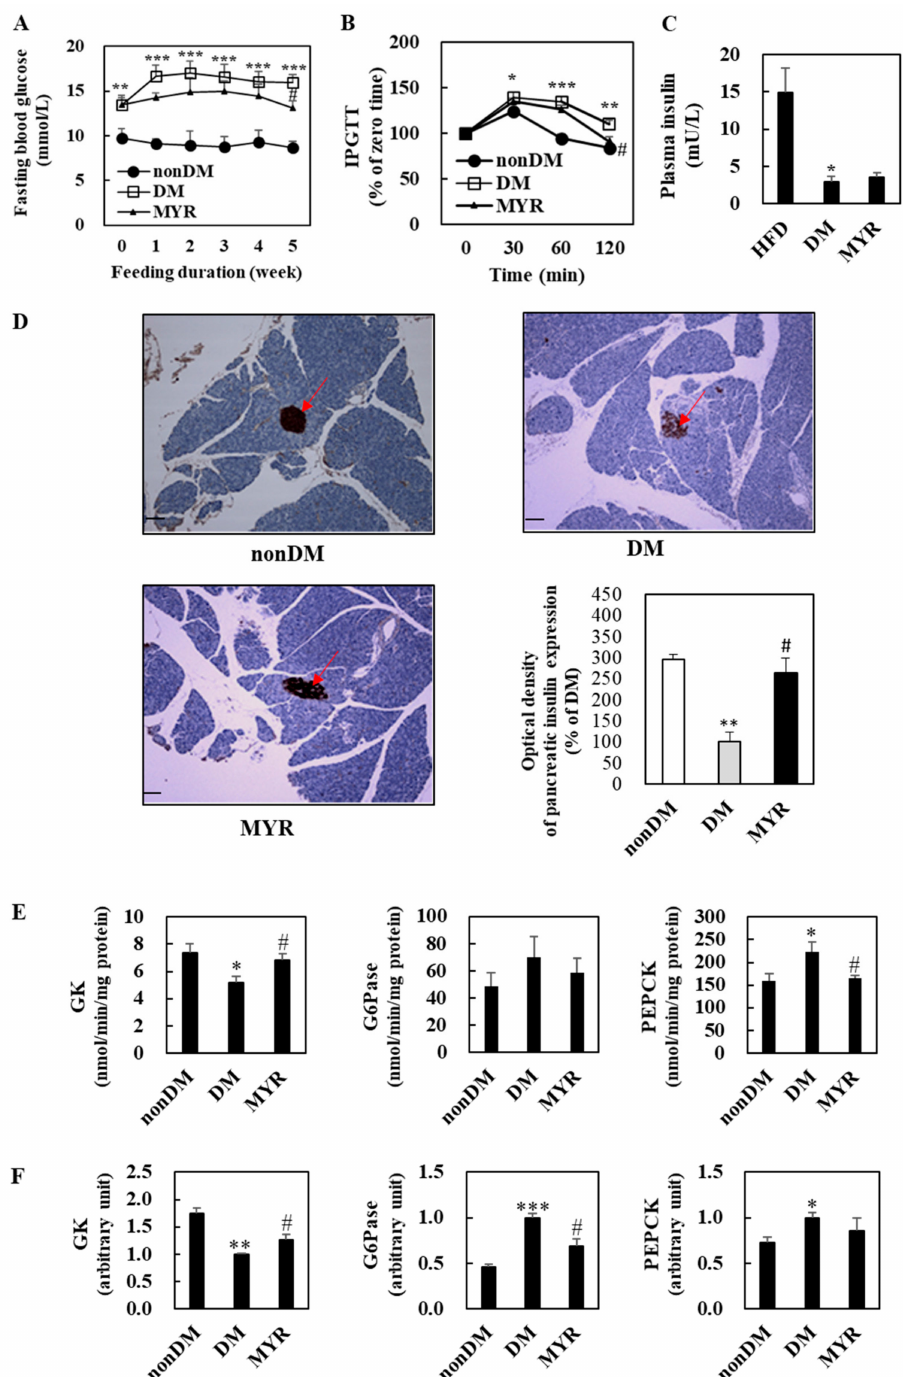
Figure 2. E ff ects of MYR on fasting blood glucose level ( A ), IPGTT ( B ), plasma insulin level ( C ), pancreas immunohistochemistry ( D ), and the hepatic glucose-regulating enzymes activities ( E ) and mRNA expression ( F ) in HFD / STZ-induced diabetic mice. ( A – F ): Values are means ± SE ( n = 10). Student’s t -test was used to assess the di ff erences among groups.: * p < 0.05, ** p < 0.01, *** p < 0.001; non-DM group versus DM group, # p < 0.05; DM group versus MYR group. ( D ): Representative images of immunohistochemical staining for insulin in pancreatic sections (arrows). Scale bars represent 19 µ m. Magnification is 100 × . IPGTT: intraperitoneal glucose tolerance test, GK: glucokinase, G6Pase: glucose-6-phosphatase, PEPCK: phosphoenolpyruvate